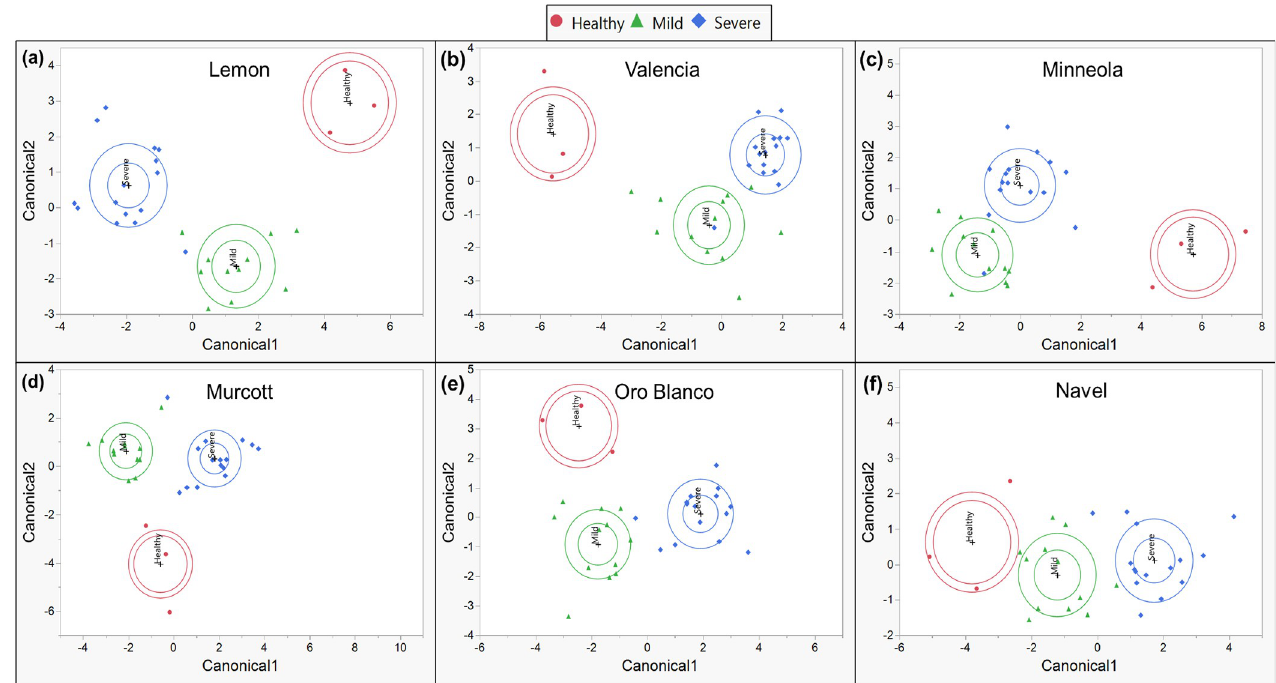
Fig 10. Canonical plots using 10 most variable individual amino acids. Canonical plots of different plants displaying mild (green-triangle), severe (blue- diamond), or no (red-circle) symptoms after CTV- or mock-inoculation, within each citrus cultivar. Canonicals were generated by stepwise discriminant analysis utilizing the 10 most variable amino acids between differentially infected plants of each cultivar. Outer ellipses are estimated 50% of the samples within a cultivar, and inner ellipses show the 95% confidence region of cultivar means.